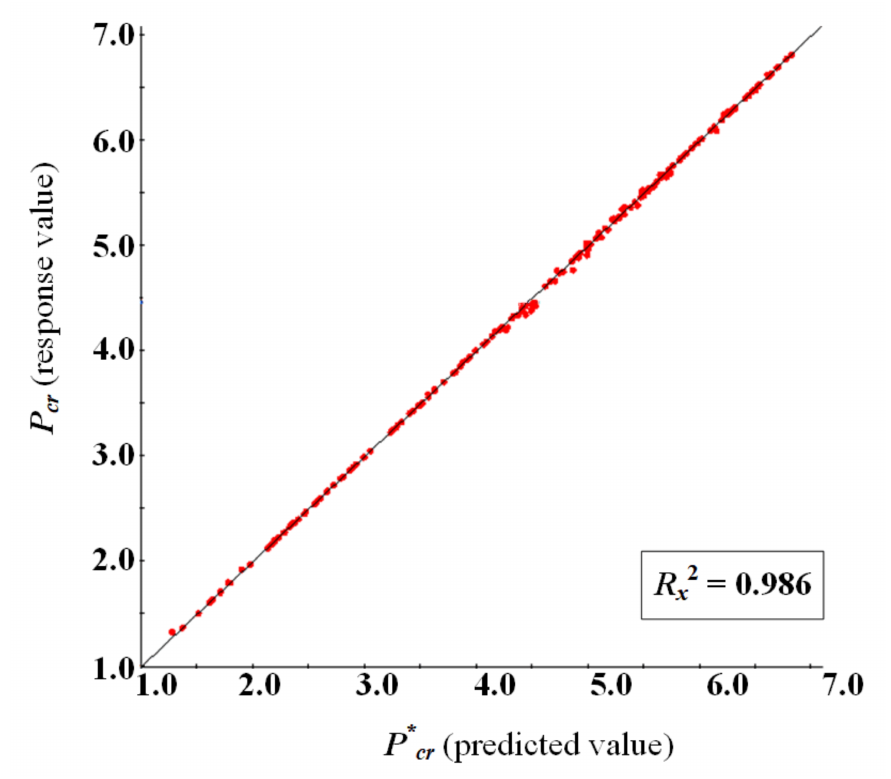
Figure 9. Error analysis with complex correlation coefficient R x 2